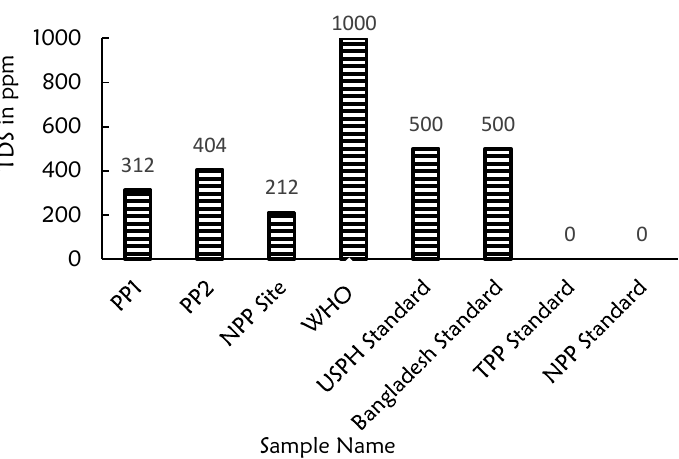
Figure 4: Analysis of TDS gap between raw water and DM water.